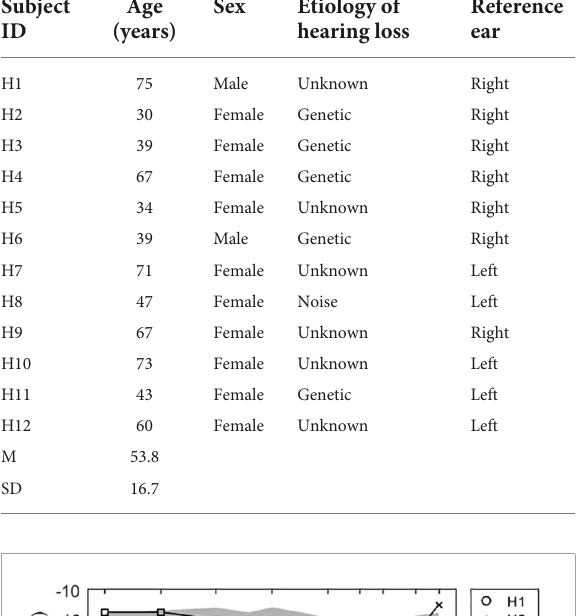
TABLE 1 Demographic information for hearing-aid (HA) users: age, sex, etiology of hearing loss, and reference ear.